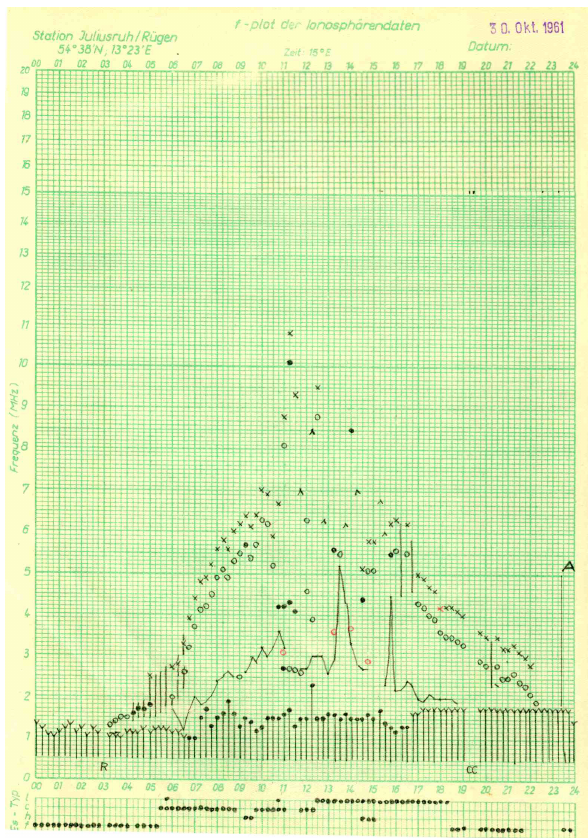
Figure 2. Original scaling results ( f plots) of the Juliusruh ionosonde measurements from the day of the fission bomb test over Novaya Semlya on 30 October 1961, and from the day after (Fig. 3); 90min after the blast, irregular variations of F Region electron den- sity commenced, lasting for nearly